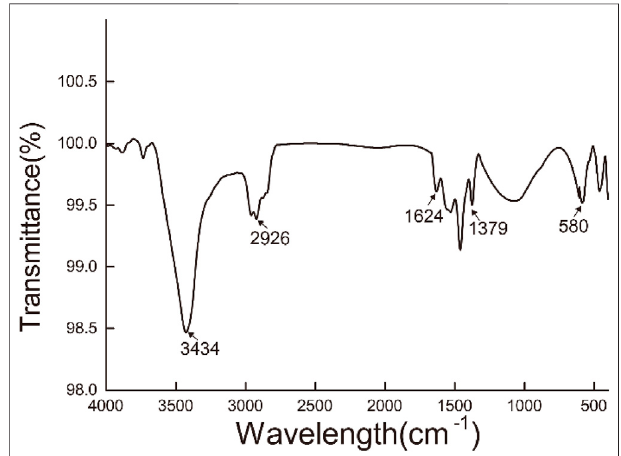
FIGURE 2 | FTIR of Fe 3 O 4